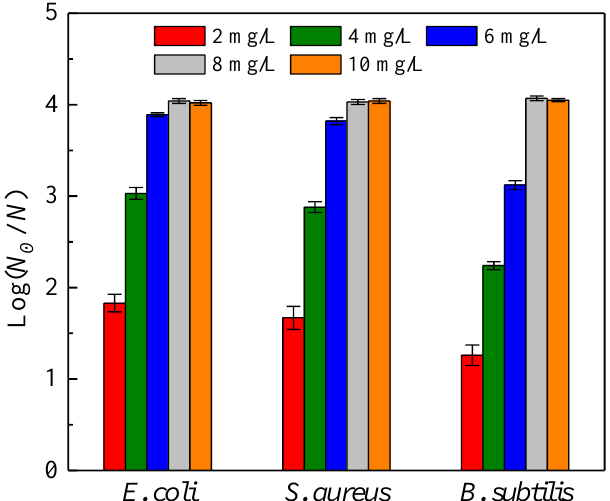
Figure 5. Log inactivation ratio at 17 + 30 kHz dual-frequency US pretreatment with different NaClO dosage (30 min chlorination time). Error bars correspond to standard error of three replicate experiments.